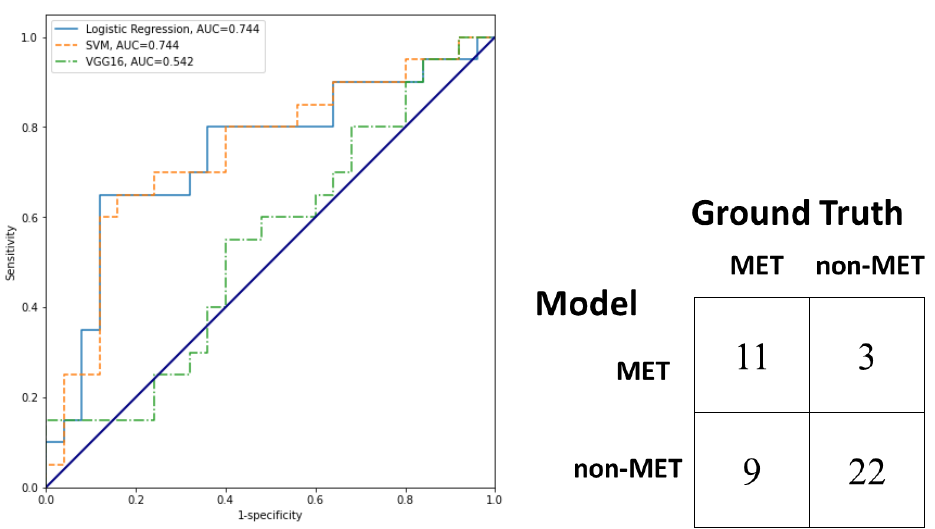
Figure 5. ROC curves of logistic regression, SVM and VGG16 model and confusion matrix of the